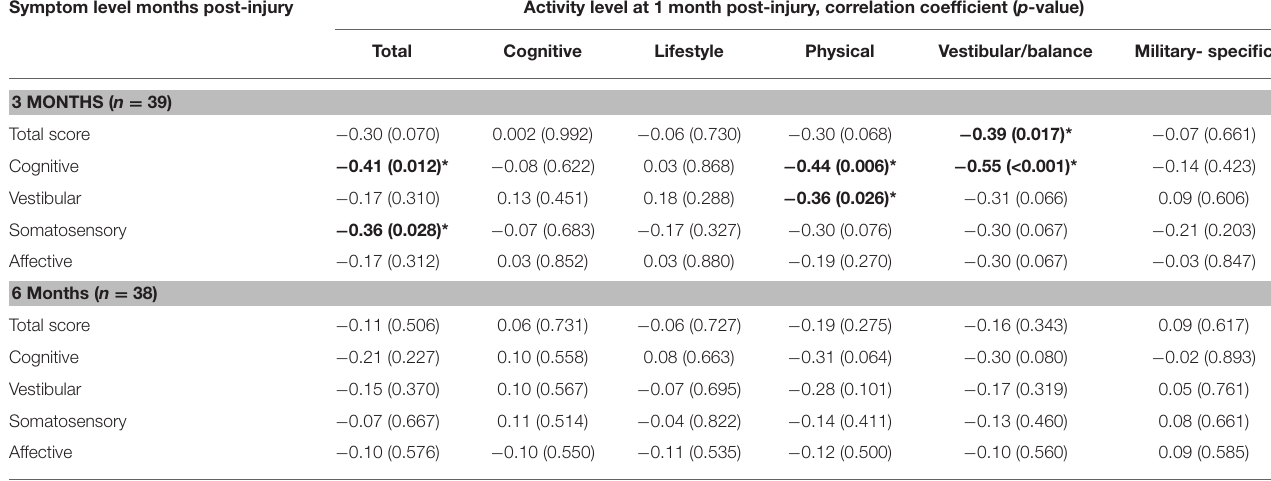
TABLE 2 | Partial correlation between activity level at 1 month (total and by categories) and symptom level at 3 and 6 months (total and by categories), adjusted for activities at acute stage of concussion and symptoms at 1 month post-injury. Symptom level months